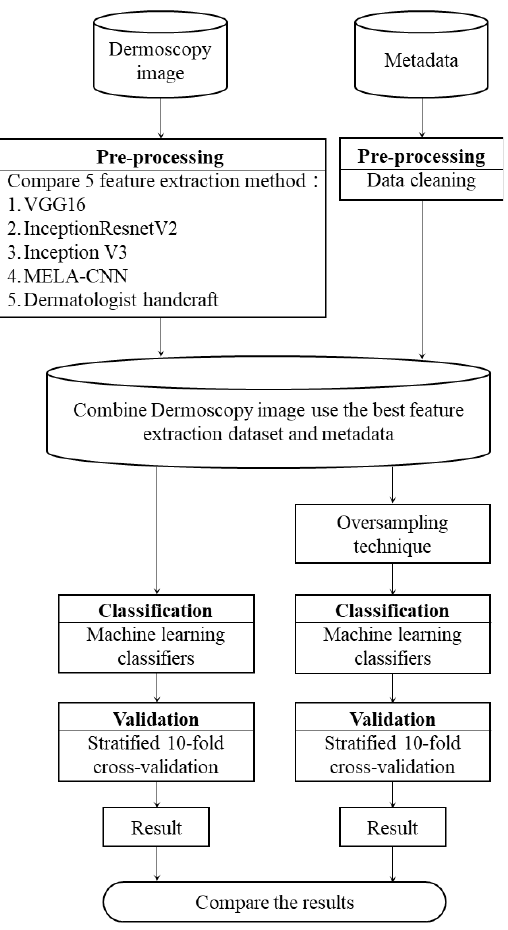
Figure 2. Research